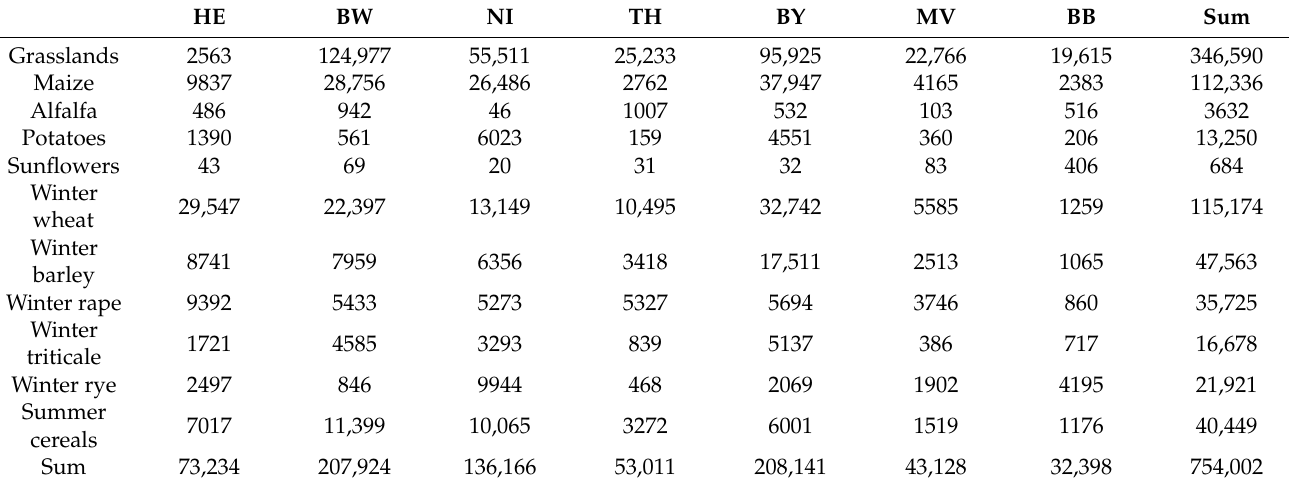
Table 1. Number of parcels per crop type in each study